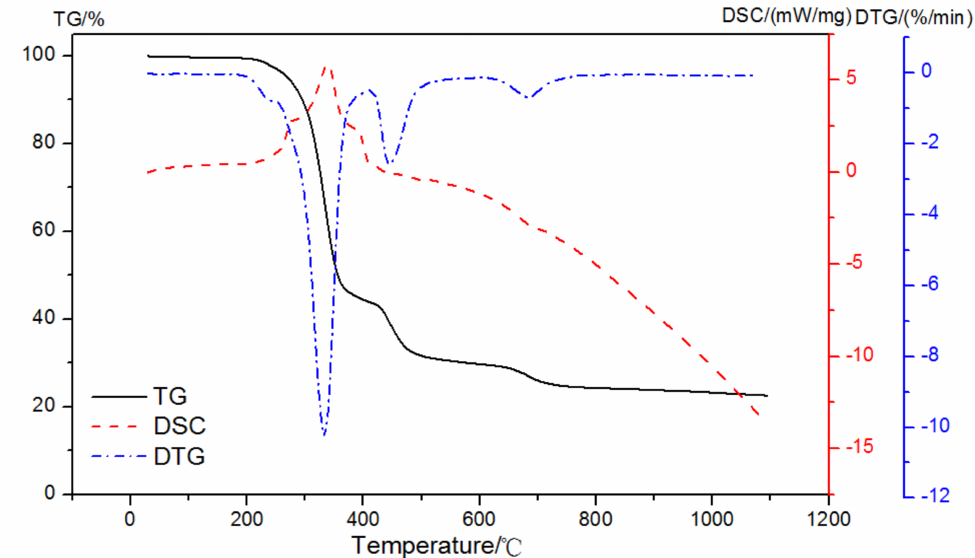
Figure 7. TG-DSC-DTG curves of EVA in a dual atmosphere. The mass loss, DTG curves, and enthalpy changes in EVA-Modified cement pastes in a dual atmosphere TG-DSC method are shown in Figure 8. The peak at a temperature of 30 ◦ C to 250 ◦ C was due to the decomposition of AFt/AFm and C-S-H gels. The second peak occurring at a temperature between 250 ◦ C and 390 ◦ C mainly originated from the oxidation reaction of EVA and decomposition of C-S-H gels. The dehydration of CH and the decomposition of EVA together led to the third peak between 450 ◦ C and 550 ◦ C in the DTG curves. The last peak at a temperature range of 650~800 ◦ C was caused by the decarbonation behavior of calcium carbonates (CaCO 3